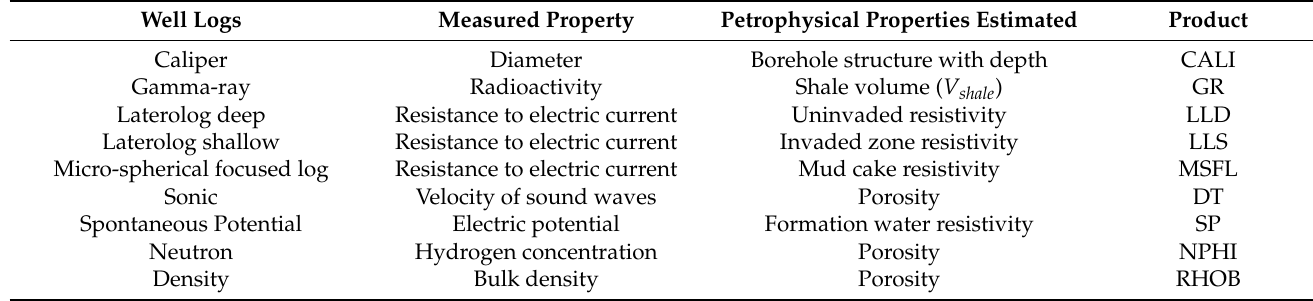
Table 1. Metadata of the utilized well logs and their uses in this